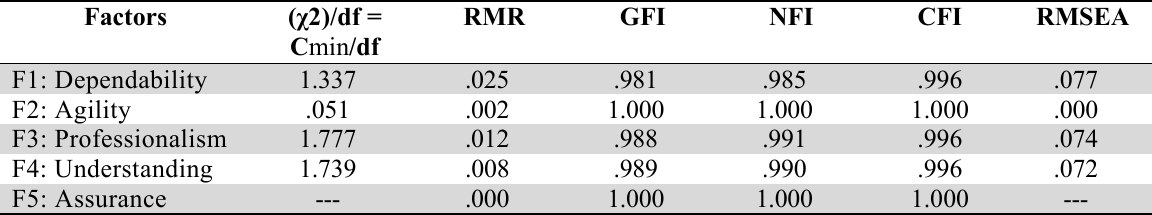
Key fit Indices for measurement model of SESQSC